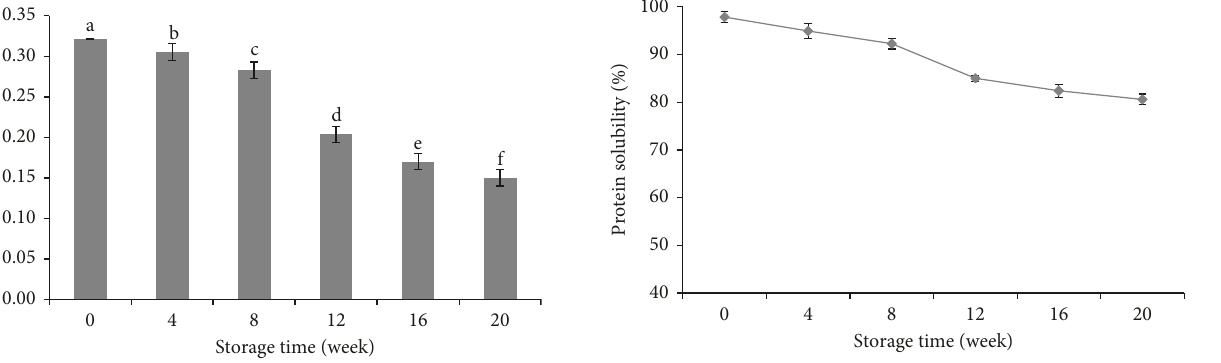
Figure 5: Changes in Ca 2+ -ATPase activities of NAM extracted from the Basa fish fillet during frozen storage at − 20 ° C for 20 weeks. Bars represent standard deviation from triplicate determinations. The different letters on the bars indicate significant differences ( p < 0 . 05).